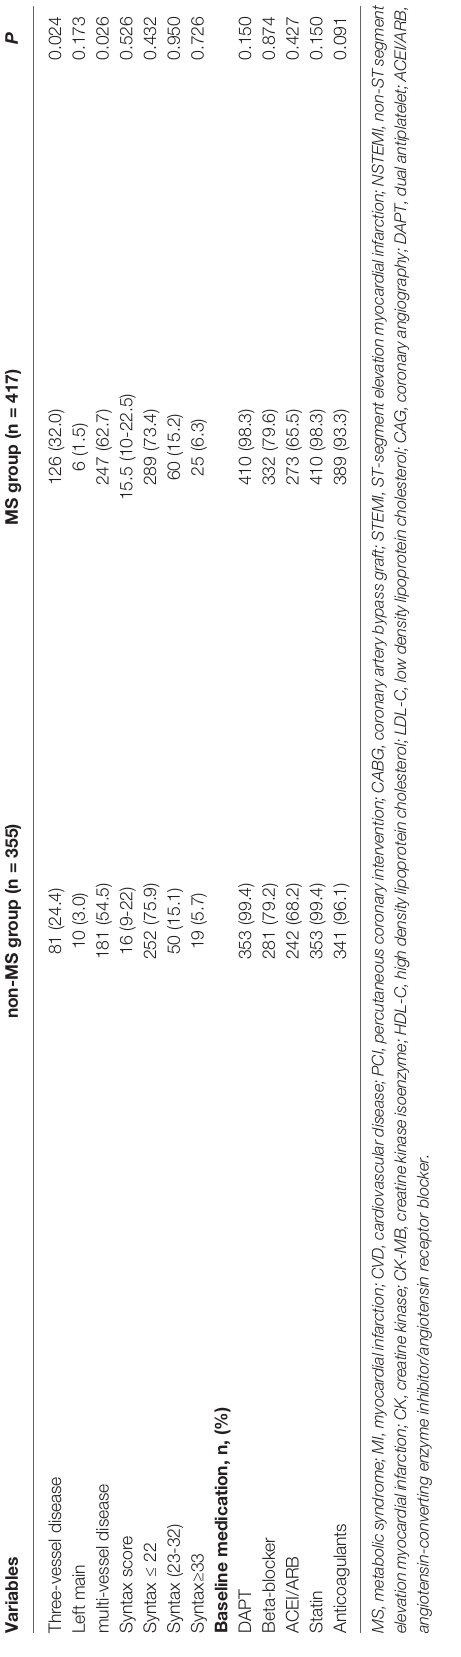
FIGURE 1 | Multivariate logistic regression analysis of impact of MS components on PMI severity. (A) Effects of MS and its components on multi-vessel disease. (B) Effects of MS and its components on Syntax score ≥ 33 Adj OR, adjusted odds ratio; CI, con fi dence